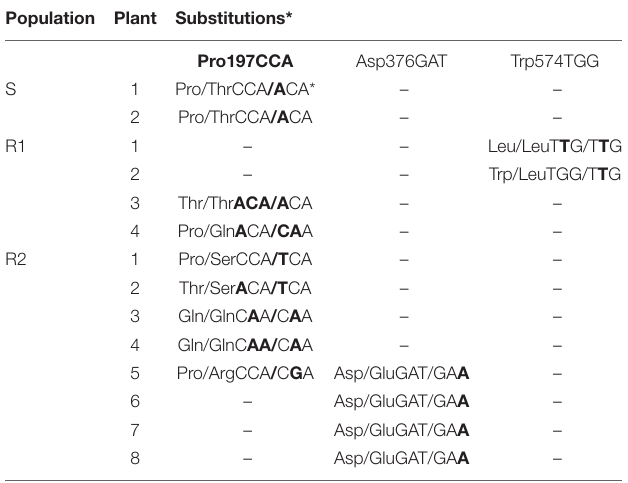
TABLE 4 | Different amino acid substitutions detected at codons Pro197, Asp376, and Trp574 of the ALS gene from S (susceptible) and R1 and R2 populations (resistant) of G. coronaria based on amino acid positions in Arabidopsis thaliana. Population Plant Substitutions*